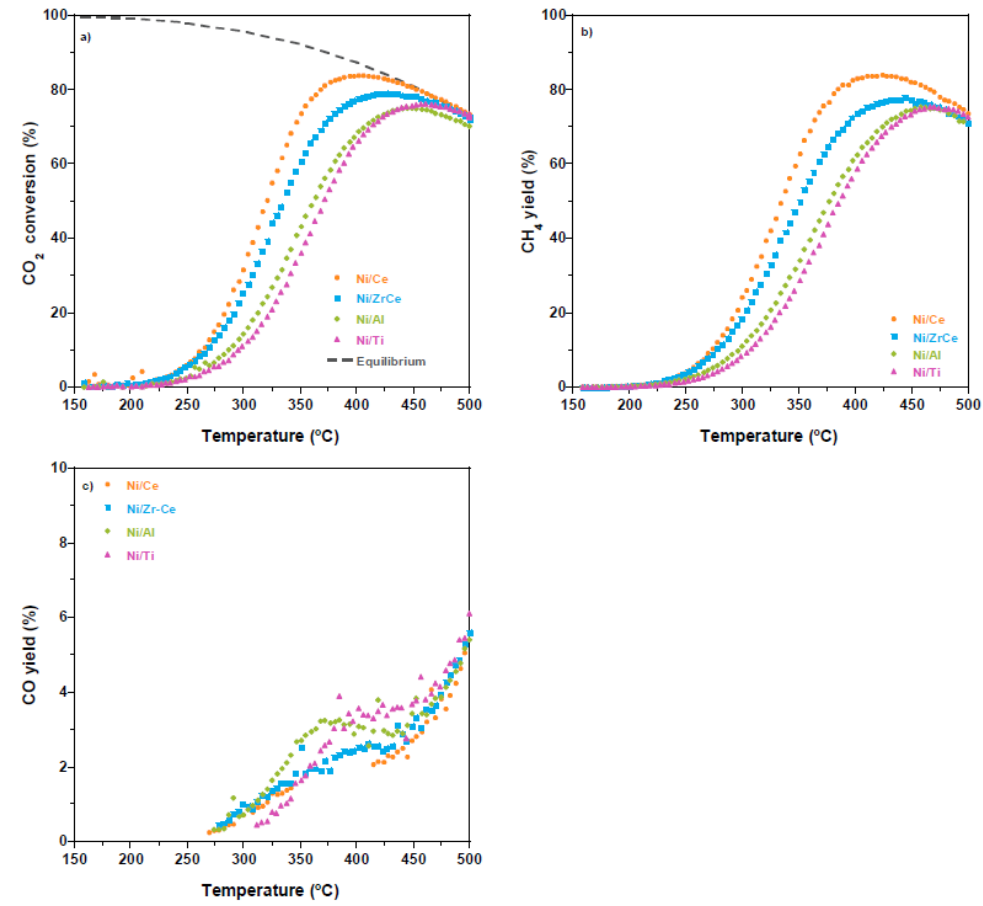
Figure 4. Evolution with reaction temperature of the CO 2 conversion ( a ), CH 4 yield ( b ), and CO yield ( c ) in methanation experiments conducted at space velocity of 12 N L CO 2 /(g cat. ·h) and H 2 /CO 2 molar ratio of 4. Dashed line in ( a ) corresponds to the calculated CO 2 equilibrium conversions.